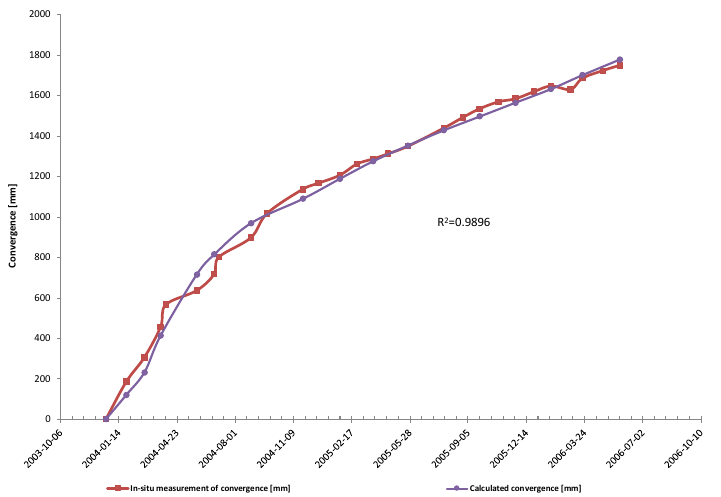
Figure 7. Numerical model for the analyzed region.